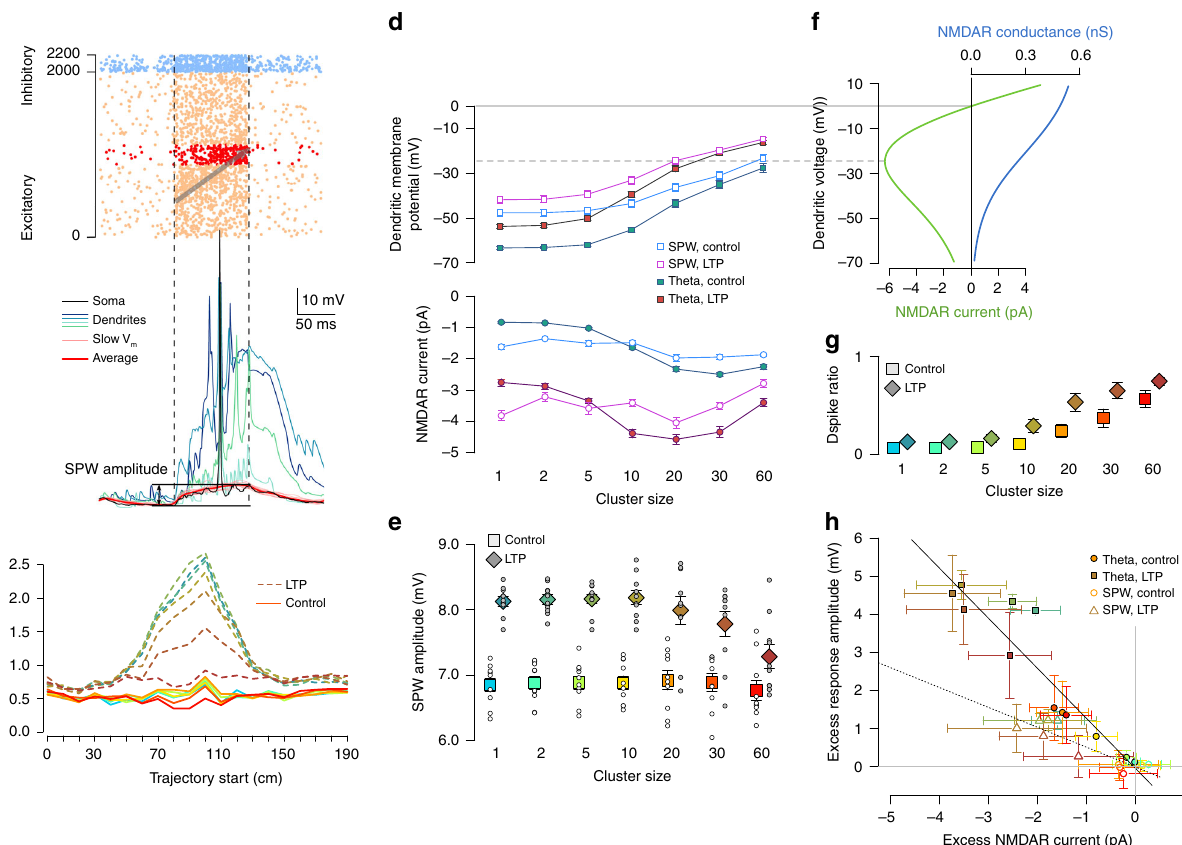
Fig. 4 Synaptic clustering have reduced impact during sharp waves. Source data are provided as a Source Data fi le. a Simulated inhibitory (blue) and excitatory (orange and red) inputs during an example SPW (vertical dashed lines). Grey arrow indicates the replayed trajectory. Red dots show activity of the clustered synapses (Fig. 3b). b Somatic (black) and dendritic (colours) membrane potential response to SPW inputs in panel a (20 synapse per cluster); pink: slow V m response in 16 trials; red: average sVm of the 16 trials, which was used to measure the amplitude of the depolarisation relative to the pre-SPW period. c Average number of somatic action potentials during individual SPW events as a function of the start location of the trajectory for control (solid lines) and LTP (dashed lines). Colour code: same as in panel e . The largest responses are when the trajectory starts at 90 and 100 cm, which are analysed further in panels d – h . d Local dendritic voltage at the synaptic clusters (top) and average NMDAR current of clustered synapses (bottom) during the maximal activity of the clustered inputs in SPW events (open symbols) and during theta state ( fi lled symbols). Error bars indicate SEM across 40 dendritic branches (top) or 40 synapses (bottom). e Mean somatic depolarisation amplitude relative to the pre-SPW baseline (SPW amplitude, see panel b ) as a function of cluster size for control (bright squares) and LTP (dark diamonds). Circles show 10 simulations with different cluster arrangements and inputs; symbols and error bars show mean and SEM. f NMDAR conductance (blue) and current (green) as a function of voltage. The peak NMDAR current is at ~ − 25 mV (dashed grey line), which was used as a dendritic spike threshold (panel g and Fig. 3g). g Mean and SEM of dendritic spike ratio during SPWs as the function of synaptic clustering across 10 simulations with 4 dendrites each. h Excess response amplitude in the soma (relative to the one synapse per cluster con fi guration) as a function of the average NMDAR current during theta ( fi lled circles) and SPWs (open circles). Symbols show mean and SD across 10 cluster arrangements (vertical) or 40 synapses (horizontal). The high variability is explained by the large diversity between dendritic branches receiving clustered